Question: Describe this figure in one sentence.
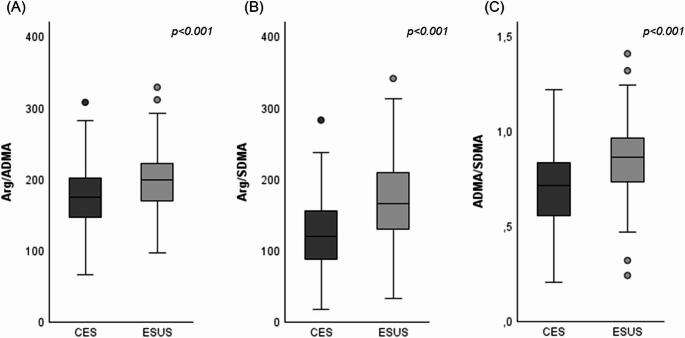
Answer: Comparison of biomarker (L-arginine (Arg), asymmetric dimethylarginine (ADMA), symmetric dimethylarginine (SDMA)) ratios between stroke etiologies: ( A ) Arg/ADMA, ( B ) Arg/SDMA and ( C ) ADMA/SDMA